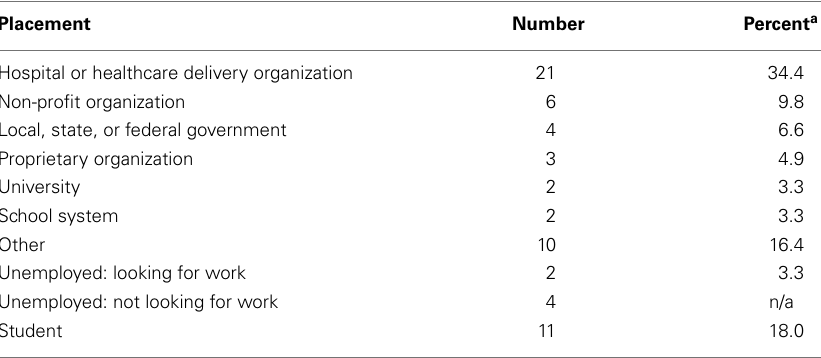
Table 1 | Reported placement data: BSPH alumni survey (2009/2010, 2010/2011,